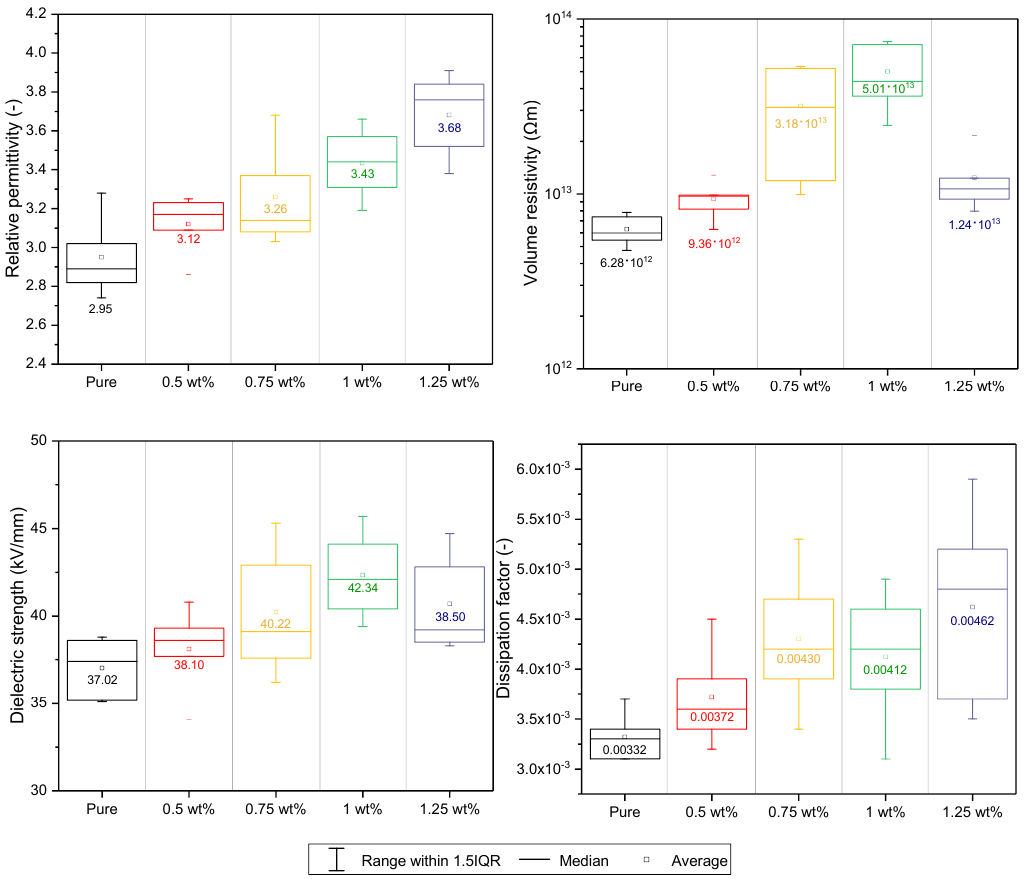
Figure 5. Analysis of dielectric parameters of Epoxy/MgO composites (adapted from: